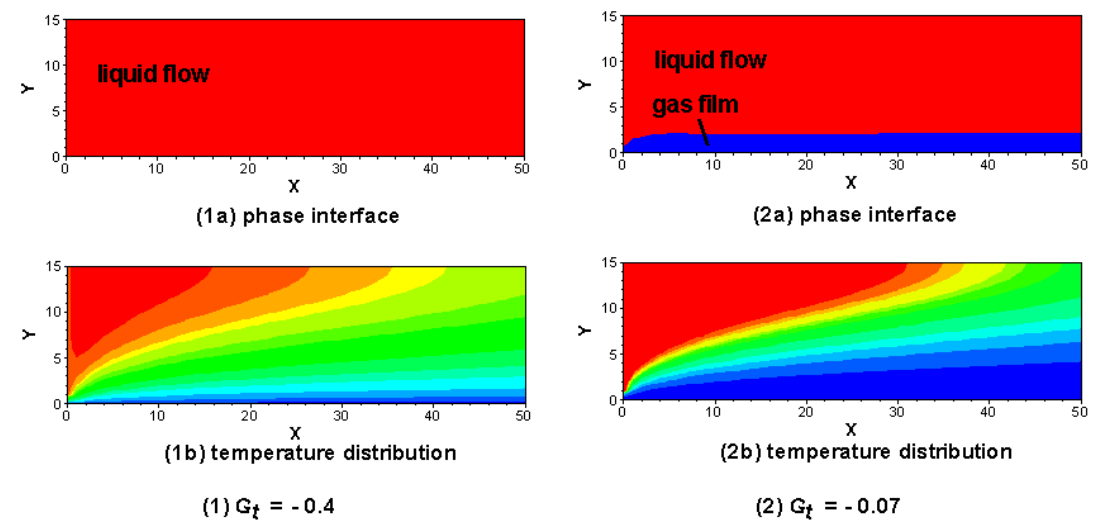
Figure 11. ( a ) Slip flow at the fluid/solid interface for a hydrophobic surface and ( b ) theoretical model for an ideal superhydrophobic surface.